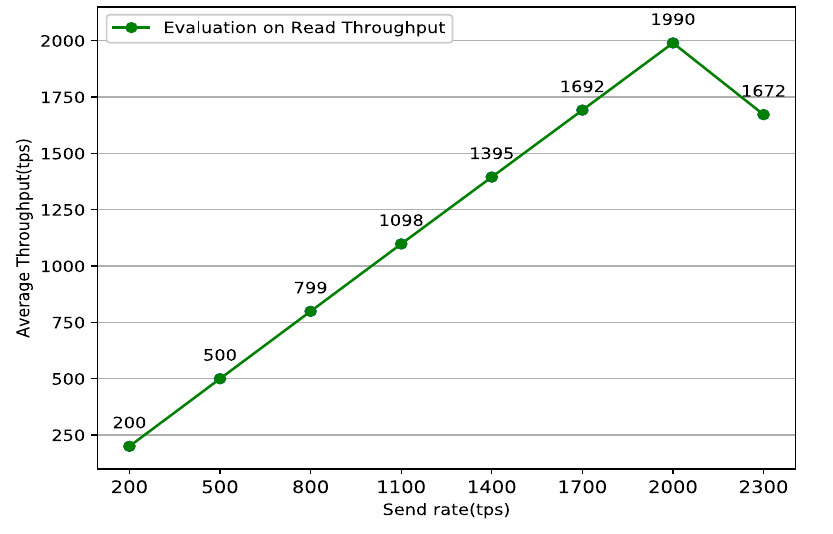
Figure 8. Evaluation on read throughput.